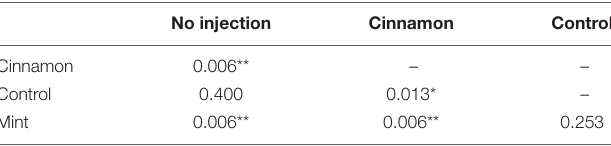
TABLE 1 | Pairwise permutational multivariate analysis of variance (PERMANOVA) comparisons for volatile organic compounds (VOCs) emissions between treatment.